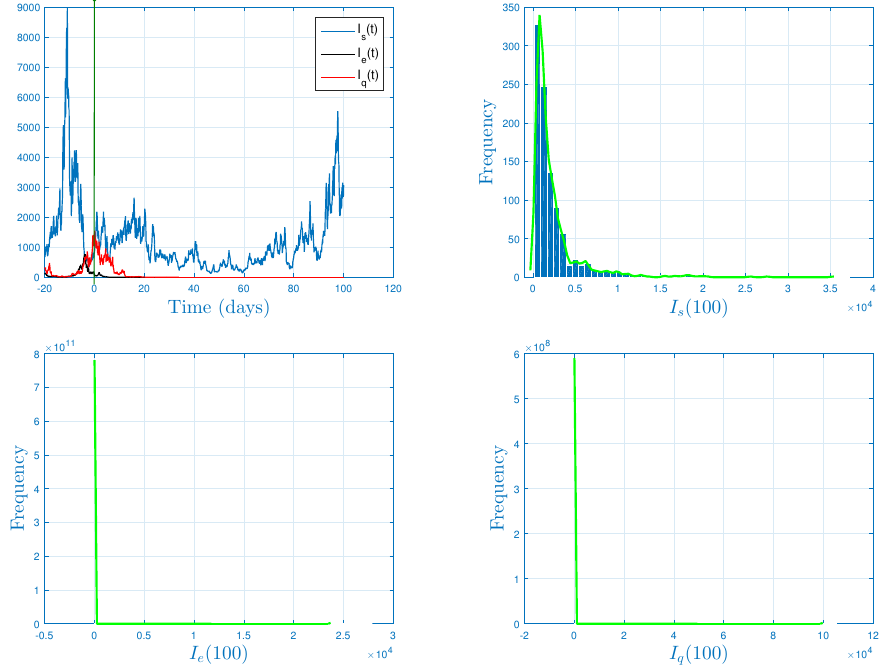
Figure 4. Stochastic paths and the associated histograms of the Ebola virus model (3) when the numerical values are taken as shown in Table 2 and the random intensities as follows: (cid:118) s = 0.05, (cid:118) e = 0.09, (cid:118) q = 0.04 and (cid:118) r =